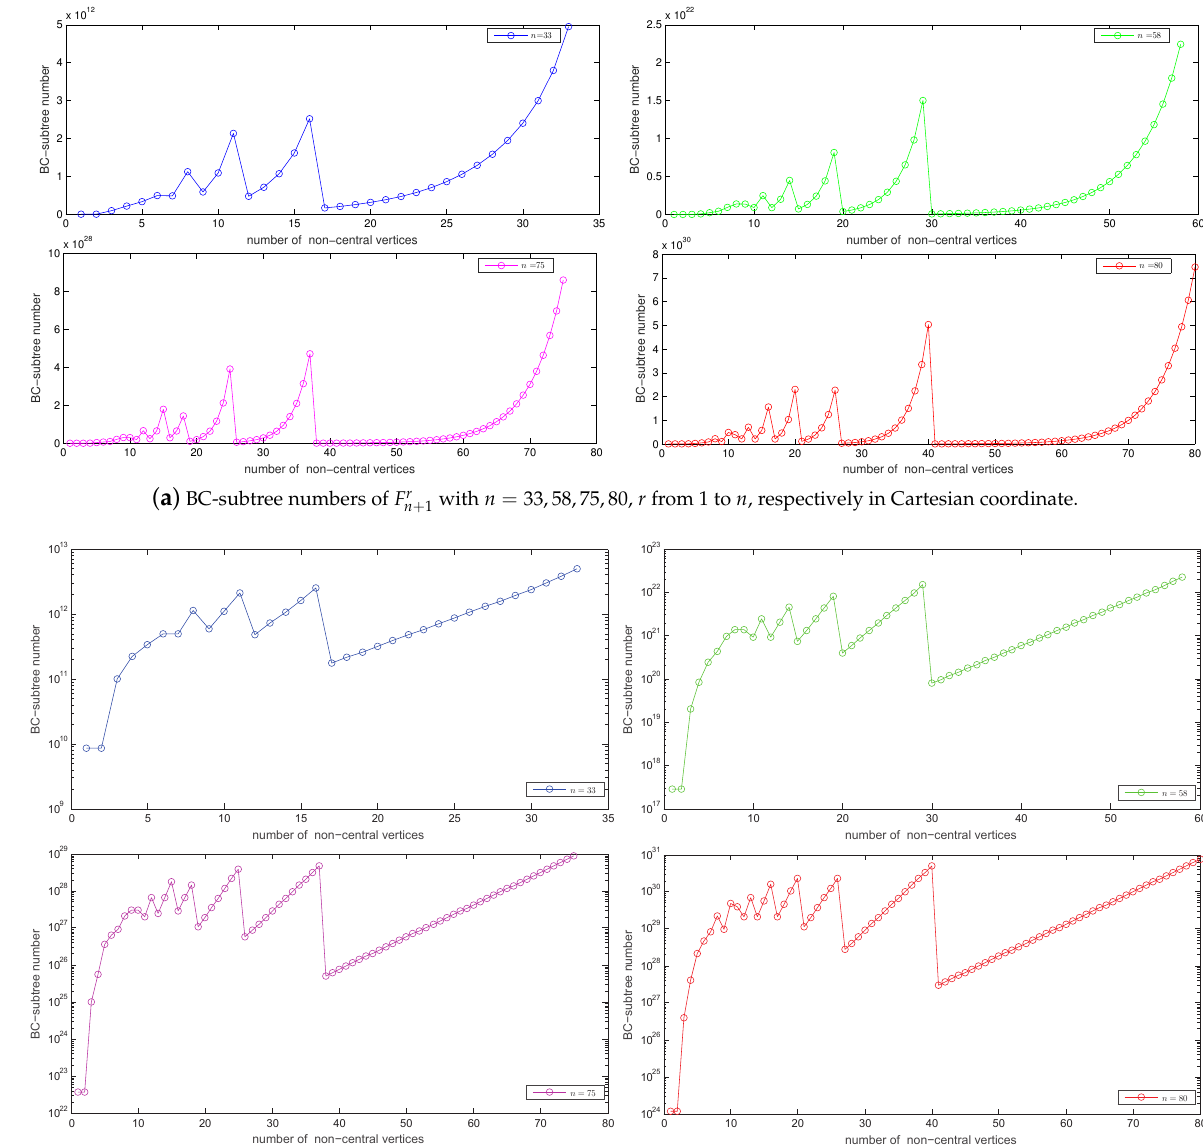
( b ) BC-subtree numbers of F r with n = 33,58,75,80, r from 1 to n , respectively in semi-log (Log-Y) coordinate. n + 1 Figure 3. BC-subtree numbers of F r with n = 33,58,75,80, r from 1 to n , respectively. n + 1 From Figure 3a, it appears that among all F r second largest BC-subtree number, and the F n − 2 number for odd (or sufficient large) n